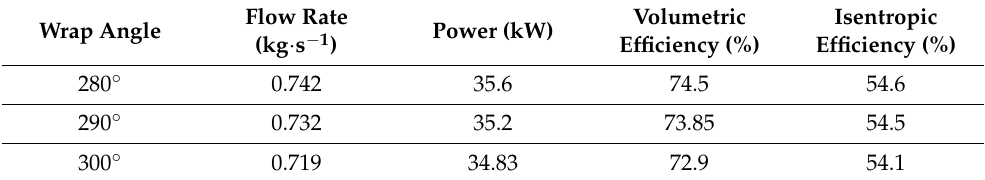
Figure 10. Temperature contours in male and female rotors. Table 3. Comparison of di ff erent wrap angles. Table 3. Comparison of different wrap angles.